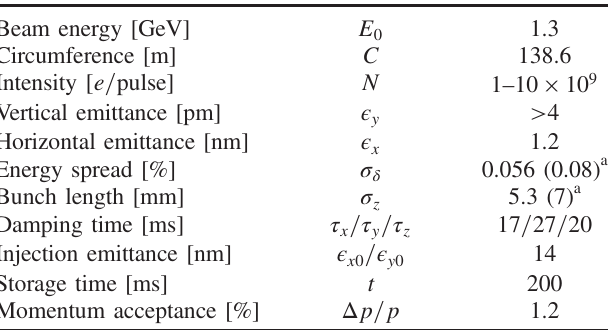
TABLE I. ATF main parameters [15,16]. Beam energy